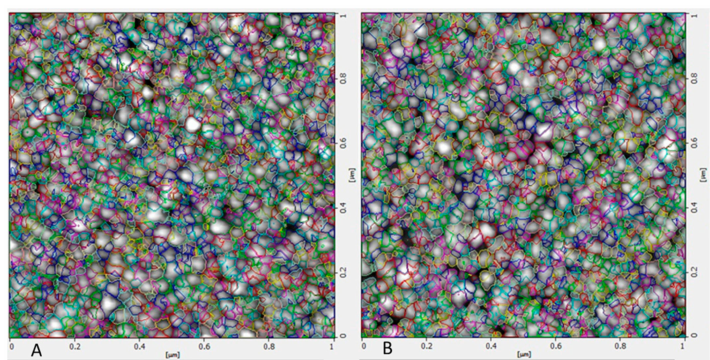
Figure 7. Atomic force microscopy images of ( A ) placebo NPs and ( B ) rotigotine-loaded NPs. Surface morphological analysis of the particles using AFM also confirmed the size range approximately 14.36 nm for placebo and 16.04 nm for rotigotine-loaded NPs nm. Topography image 1 micrometer × 1 micrometer of the same region.